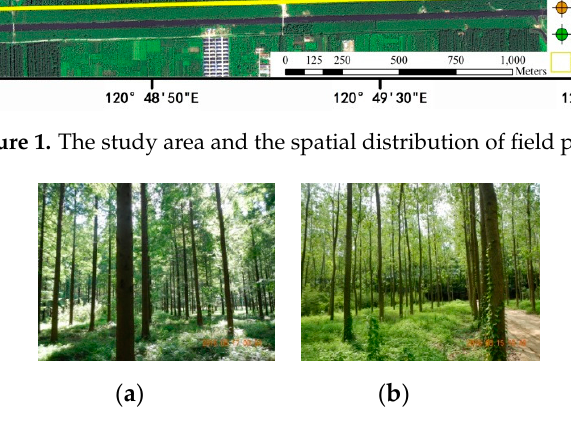
Figure 2. Two tree species in the study site ( a ) Metasequoia and ( b ) Poplar .